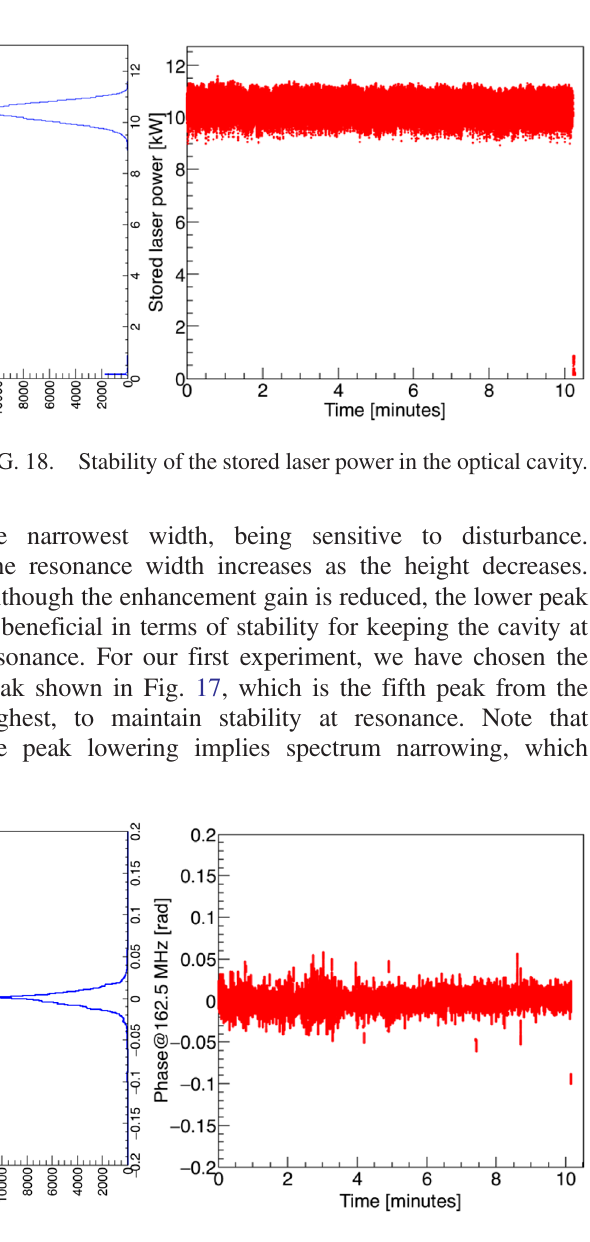
FIG. 19. Stability of the laser phase in phase locking